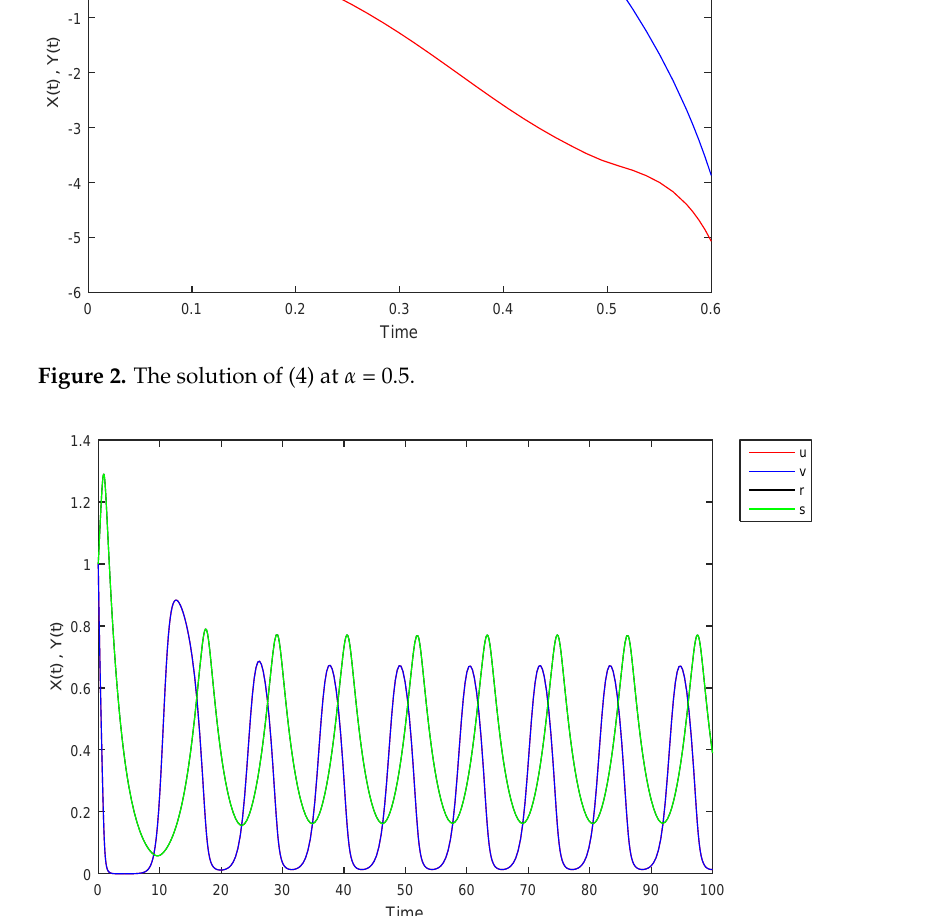
Figure 3. The solution of (4) at α =